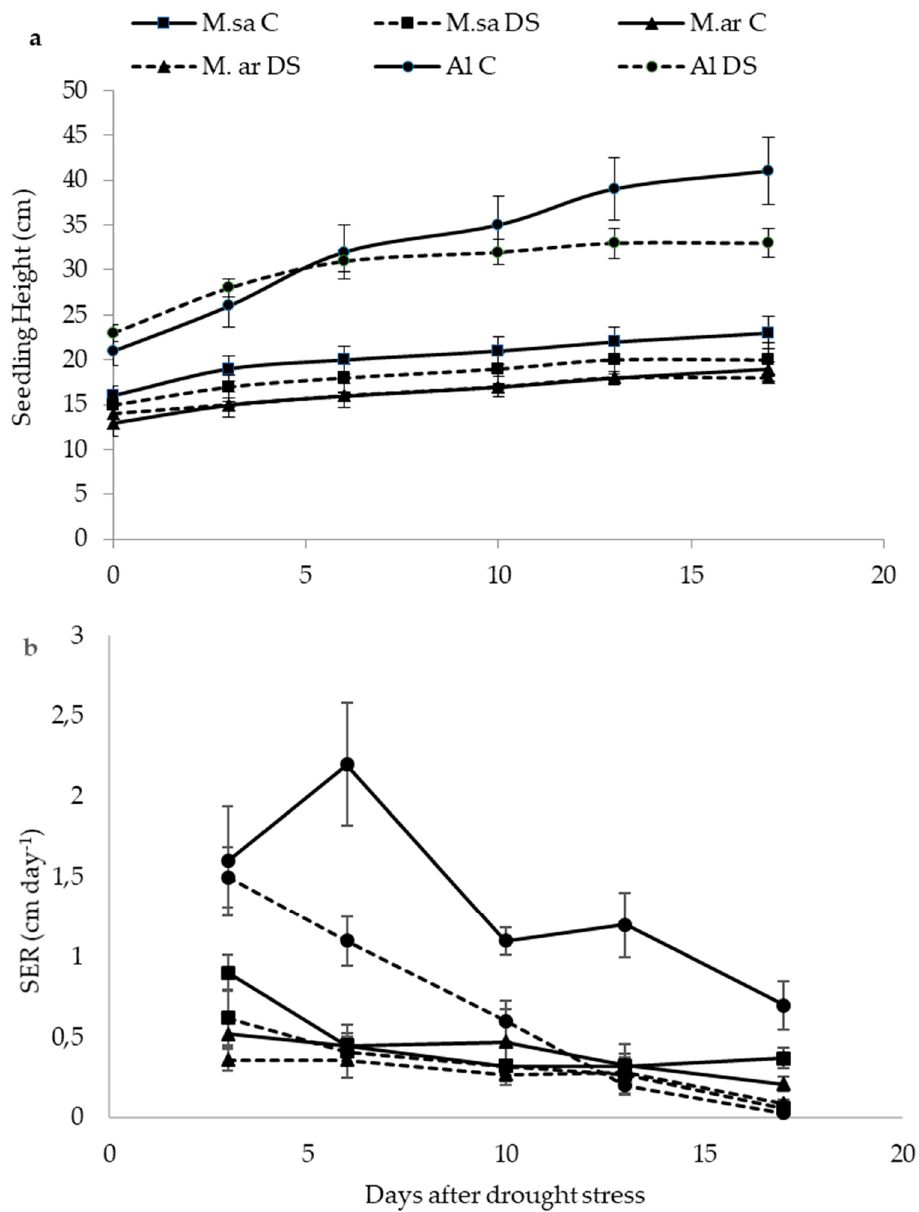
Figure 1. The seedlings height ( a ), and the seedlings Stem Elongation Rate (SER) ( b ) of M. arborea (M.ar), M. sativa (M.sa) and Alborea (Al) under control (C) and drought stress (DS) during the experimental period.Error bars indicate the mean SE.